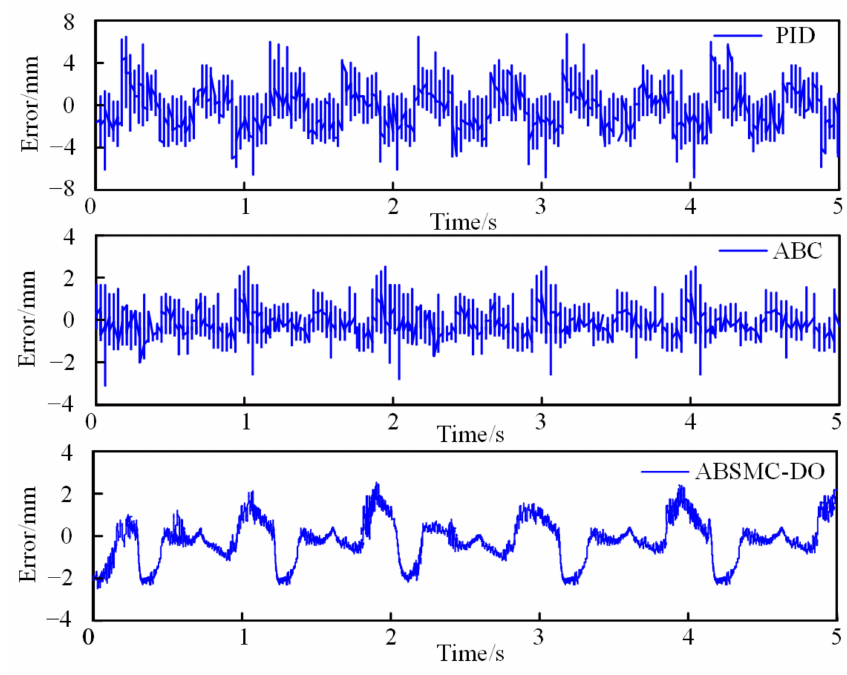
Figure 8. Tracking errors of different controllers with no disturbance.